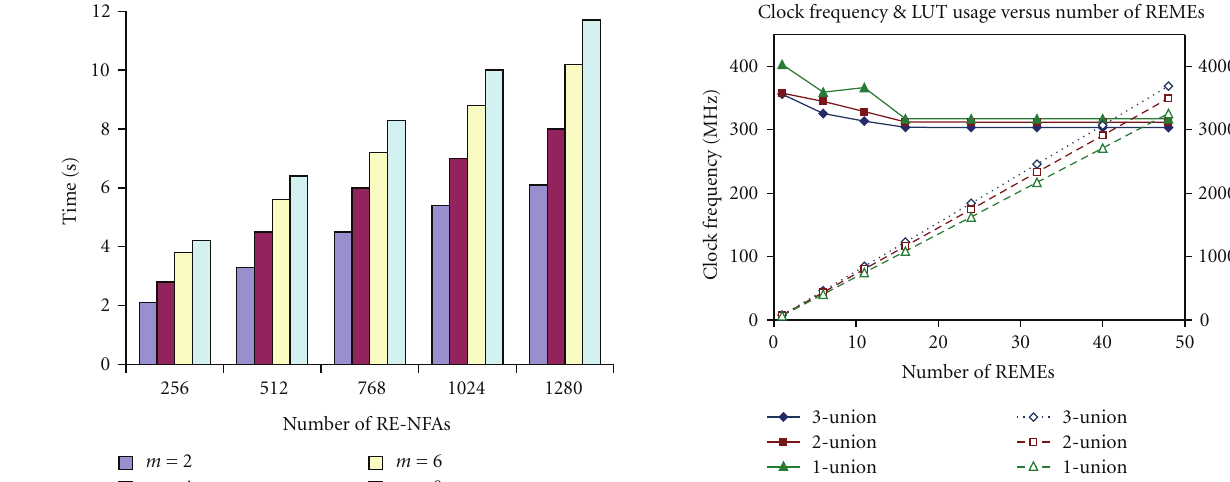
Figure 10: REME construction time for various number of regular expressions and multi-character matching parameters.